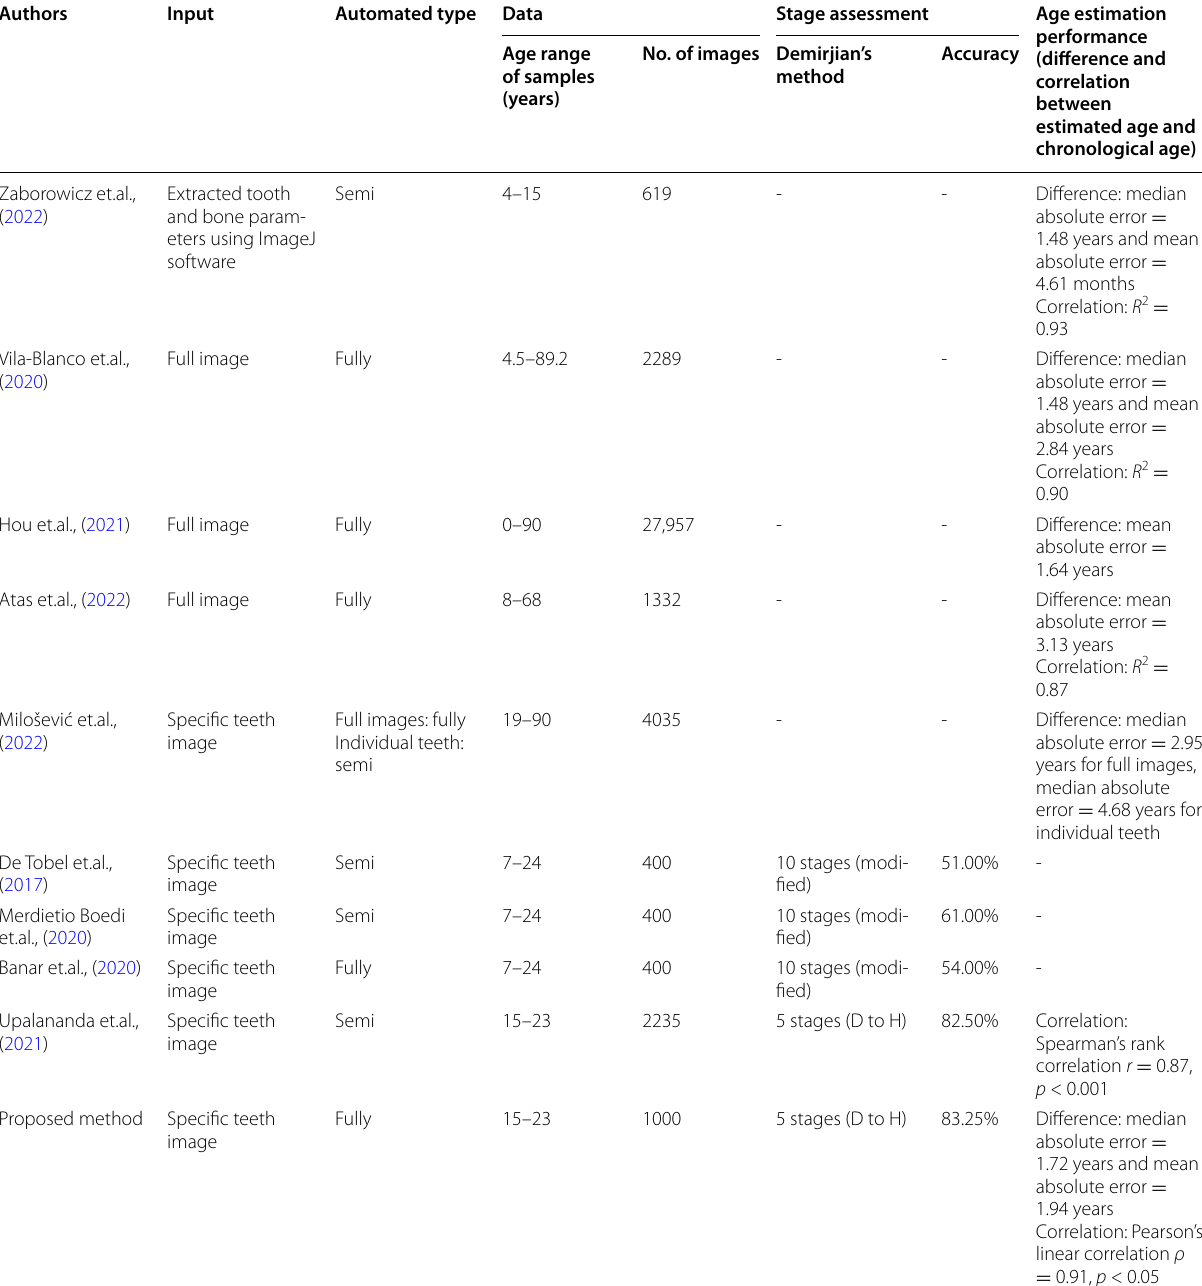
Table 4 Comparison between the proposed method and previous studies on dental age assessment using dental panoramic